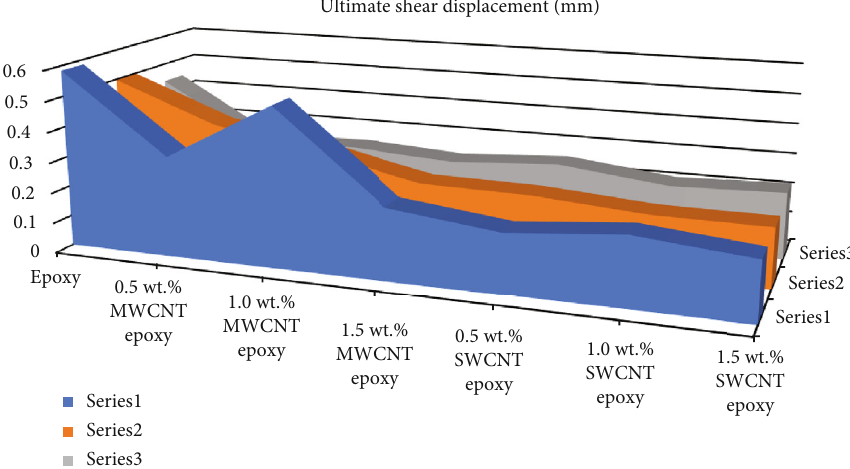
Figure 9: Average ultimate shear displacement results for CNT-epoxy composite specimens obtained from the short-beam